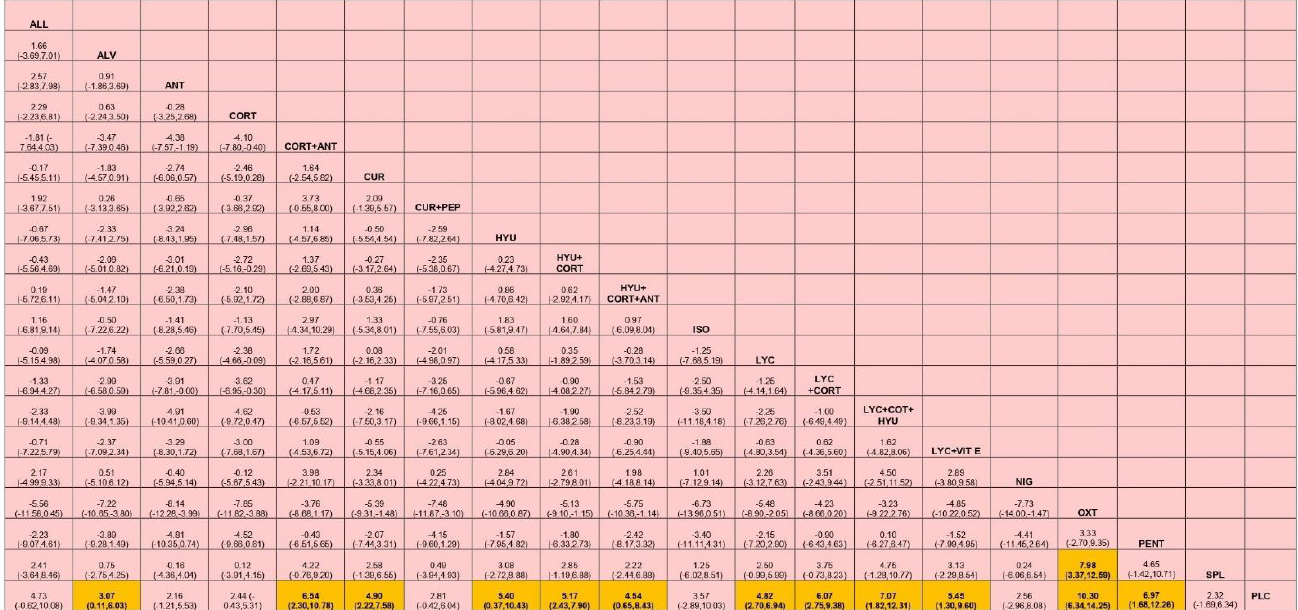
Figure 4. League table showing the results of the network meta-analyses comparing the effects of all drugs in improving mouth opening (MD) and 95% credible intervals. Abbreviations: HYU —